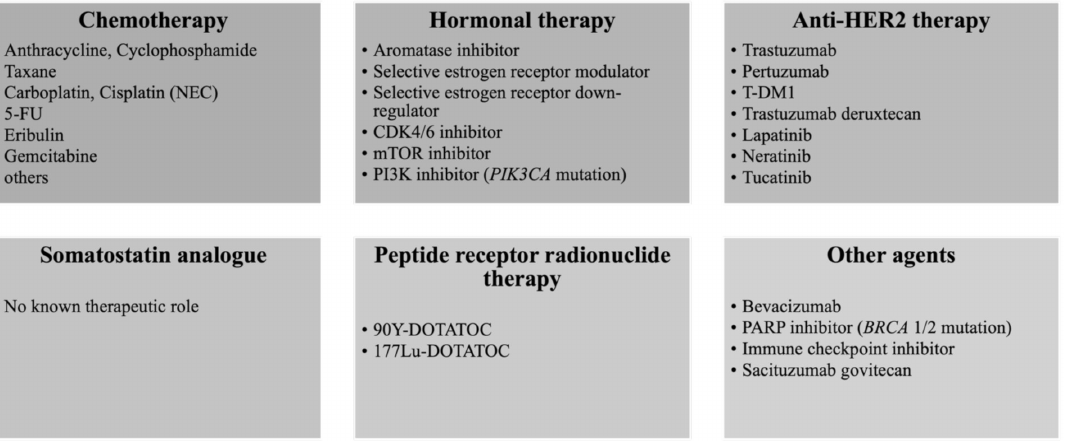
Figure 6. Systemic therapy for recurrent or metastatic Br-NEN. Systemic therapy for recurrent or metastatic Br-NEN including chemotherapy, hormonal therapy for HR-positive disease, anti-HER2 therapy for HER2-positive disease, somatostatin analogue, peptide receptor radionuclide therapy, and other